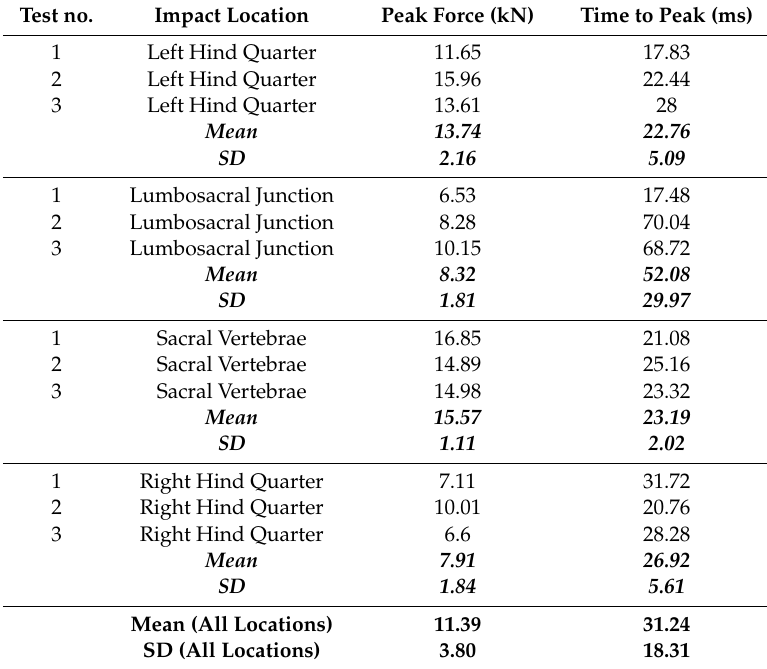
Table 1. Un-helmeted drop test results for horse 1.